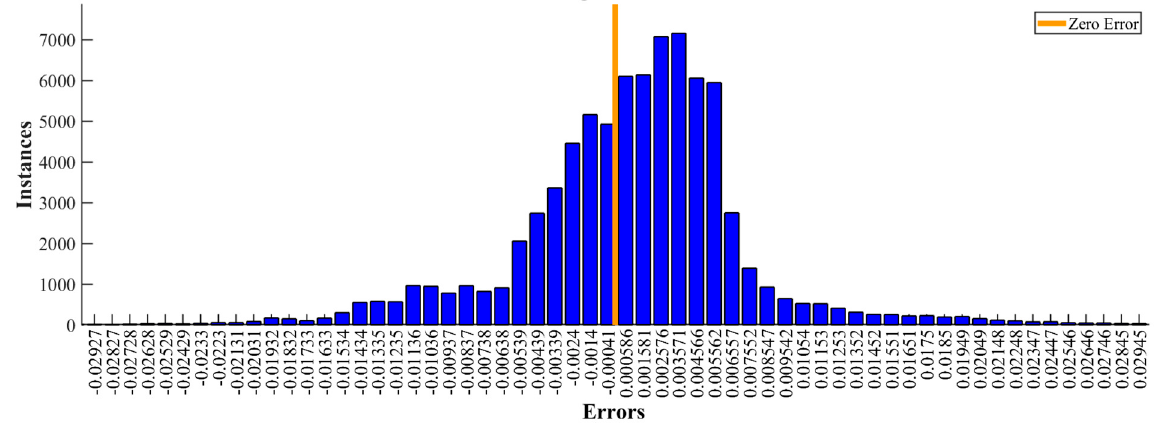
Figure 8. Error histogram for unsprung mass relative velocity prediction compared to the reference.